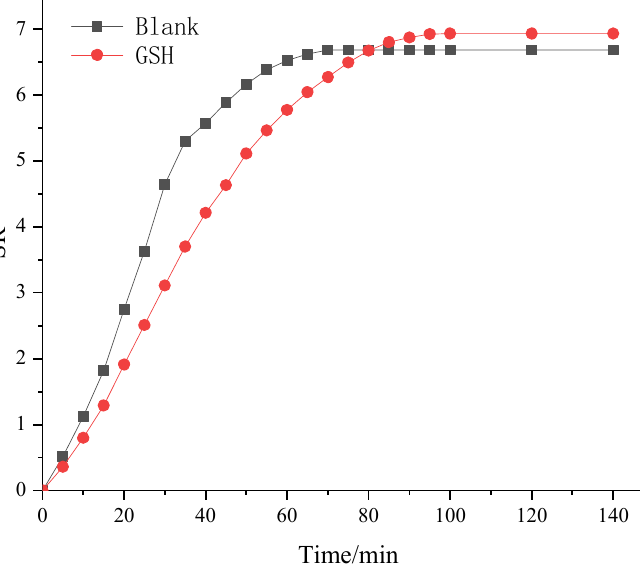
Figure 8. Gel swelling equilibrium in GSH response.